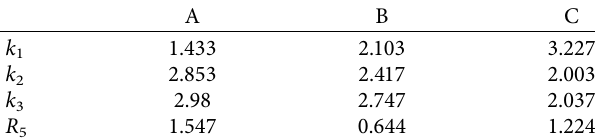
5 ) of paste filling.